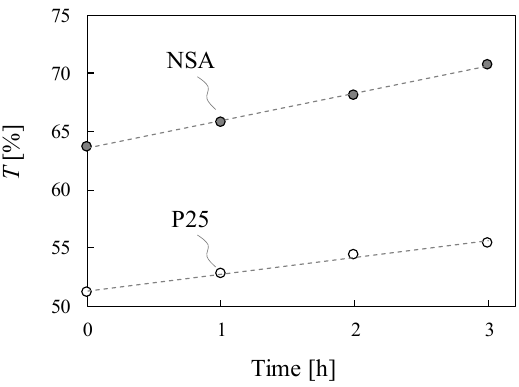
Figure 8. Transmittance variation with time during photocatalytic methylene blue (MB) decomposition.